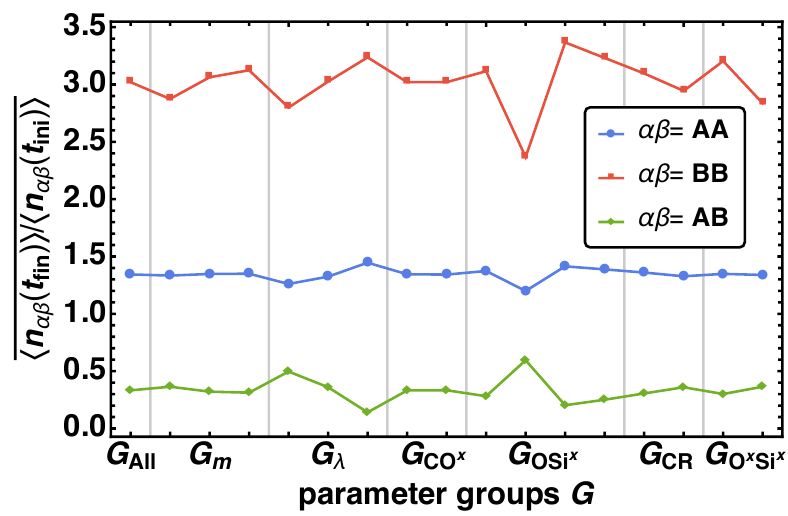
Figure 7. Averaged mean nearest-neighbor contacts (cid:104) ˆ n αβ ( t fin ) (cid:105) / (cid:104) ˆ n αβ ( t ini ) (cid:105) for all parameter groups G ( i ) for the bead type combinations αβ = { AA, AB, BB }